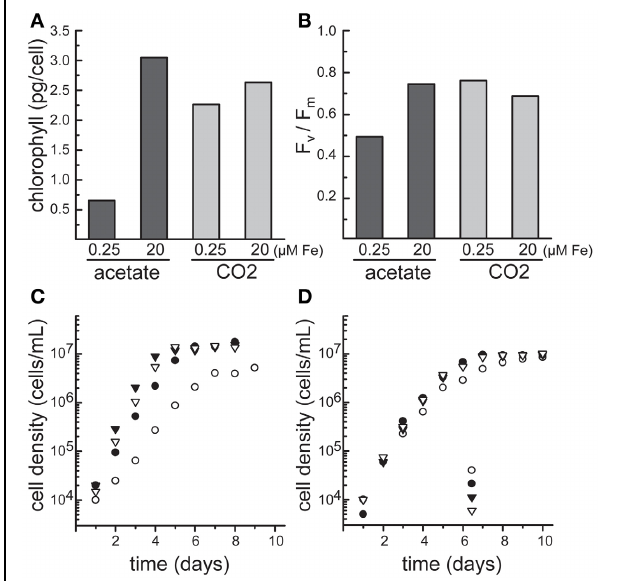
FIGURE 1 | The growth of Chlamydomonas CC-4532 in response to iron supplementation depends on the carbon source. Cells were cultured in TAP for photoheterotrophic growth (acetate) or TP for photoautotrophic growth (CO 2 ) using the revised trace metal supplement (Kropat et al., 2011) at 24 ◦ C and shaken at 180rpm under continuous illumination of 70–80 µ mol/m 2 s, and bubbled with sterile air. (A) Determination of chlorophyll content and (B) maximum quantum efficiency of photosystem II ( F v / F m ). Aliquots of cells grown photoheterotrophic (dark gray) and photoautotrophic (light gray) were removed from the culture during the logarithmic growth phase ( ∼ 4 × 10 6 cells/ml). (C) Photoheterotrophically and (D) photoautotrophically grown cells at 0.25 µ M (open circles), 1 µ M (filled circles), 20 µ M (filled inverted triangles) and 200 µ M Fe (filled inverted triangles) were counted with a hemocytomer for estimation of growth